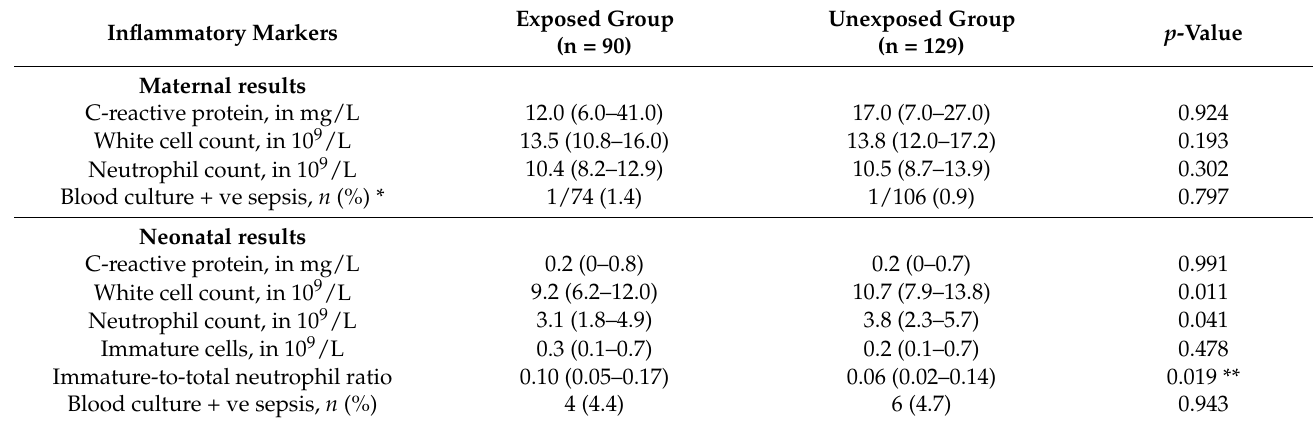
Table 2. Comparison of inflammatory markers among preterm neonates and mothers who gave birth to a preterm neonate (<34 weeks